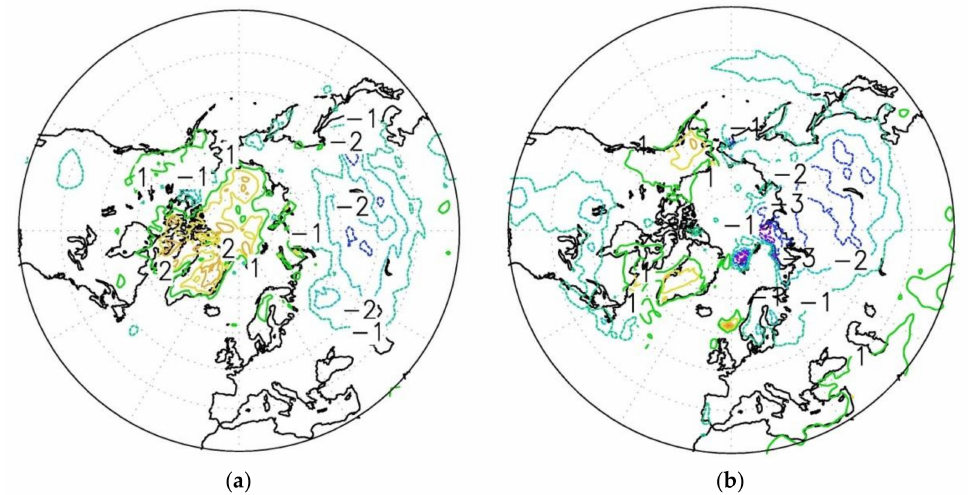
Figure 11. Change of surface temperature between the “warm” and “cold” winter composites averaged over November–December ( a ) and March–April ( b